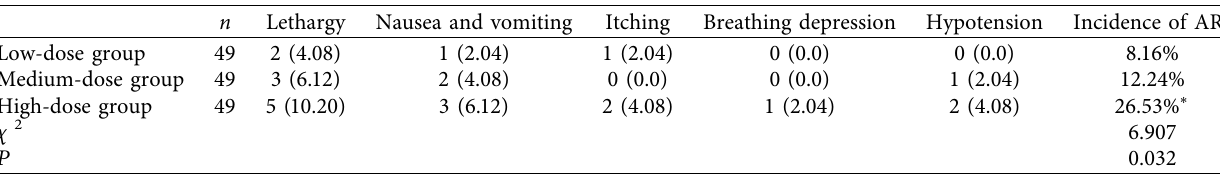
Table 2: Comparison of ARs.